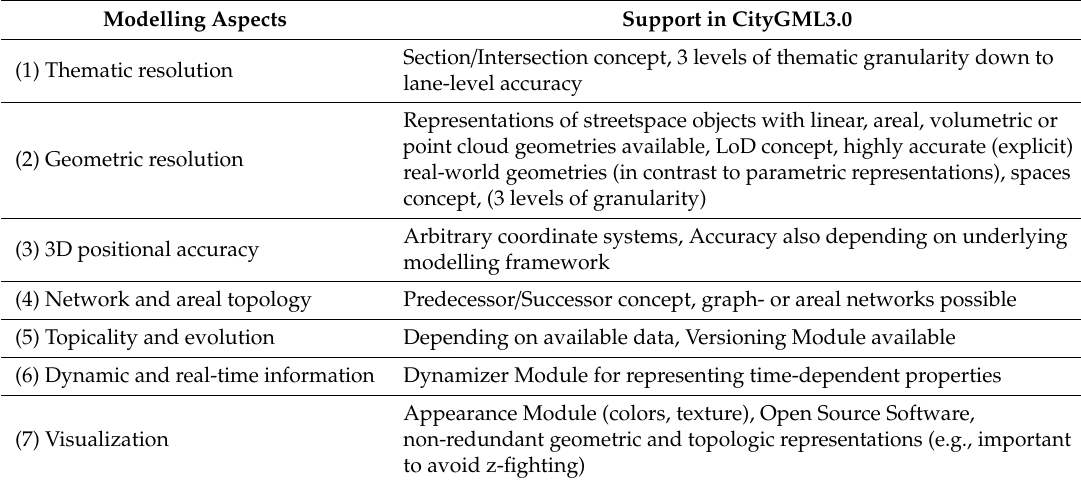
Table 2. Meeting modelling aspects with